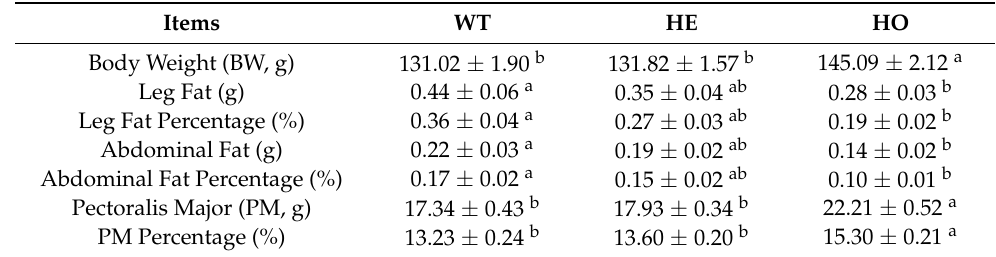
Table 1. Adipose and muscle weights, and percentage of each tissue compared to body weight of WT, HE, and HO quail hens at 4 months